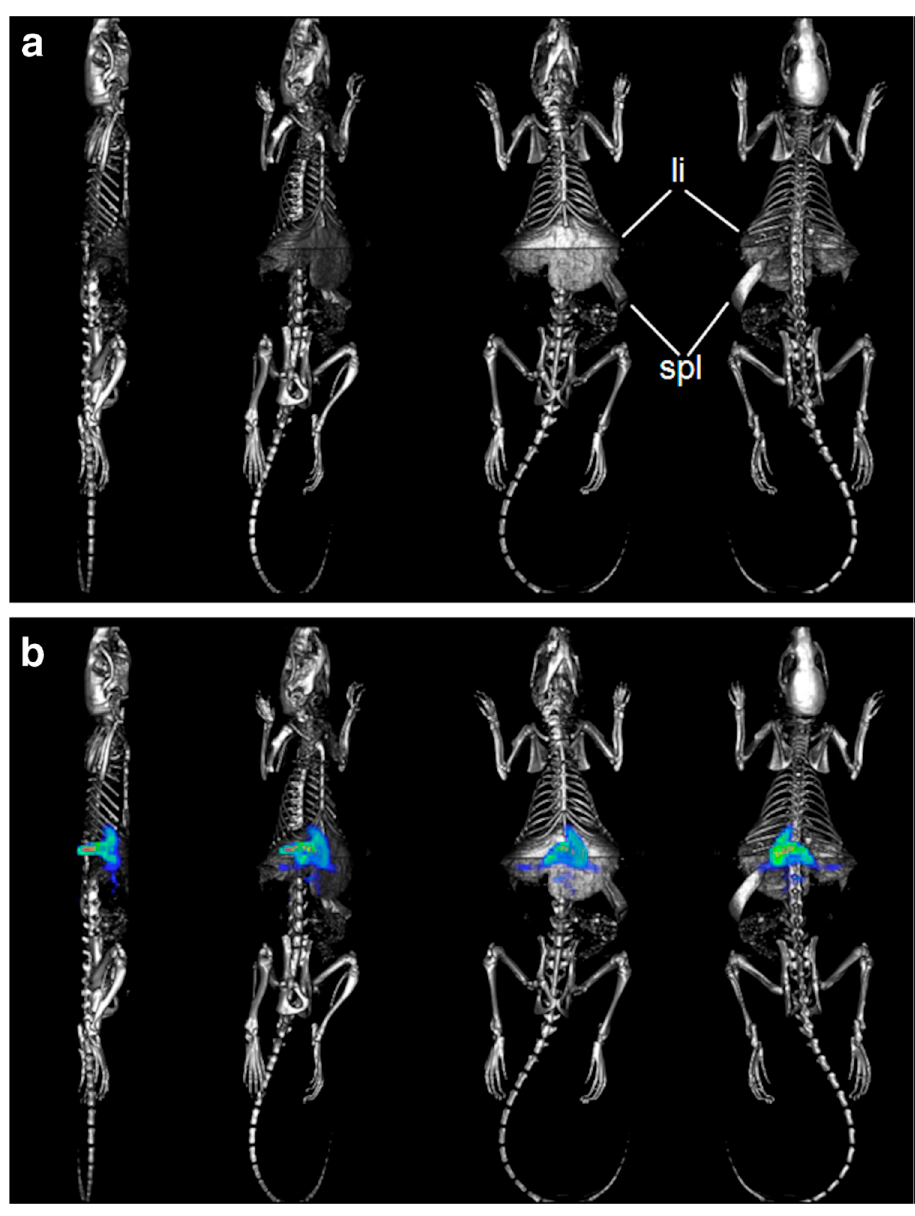
Figure 12. Accumulation of liver-targeted imaging agents 6 h after simultaneous injection with ExitronNano 1200 BSA_VT750. The animals (160 g Wistar rat; n = 1) were imaged in both modalities, and the scans were co-registered based on the fiducial marks. The 3D rendered volumes are shown in four different views rotated around the anteroposterior axis (second-last view: ventral, last view: dorsal). ( a ) Micro-CT, the barium sulfate nanoparticles accumulate in the liver (li) and the spleen (spl), resulting in enhanced X-ray contrast; ( b ) Micro-CT merged with FMT. Reprinted with permission from [118], Copyright [2014],.Springer.